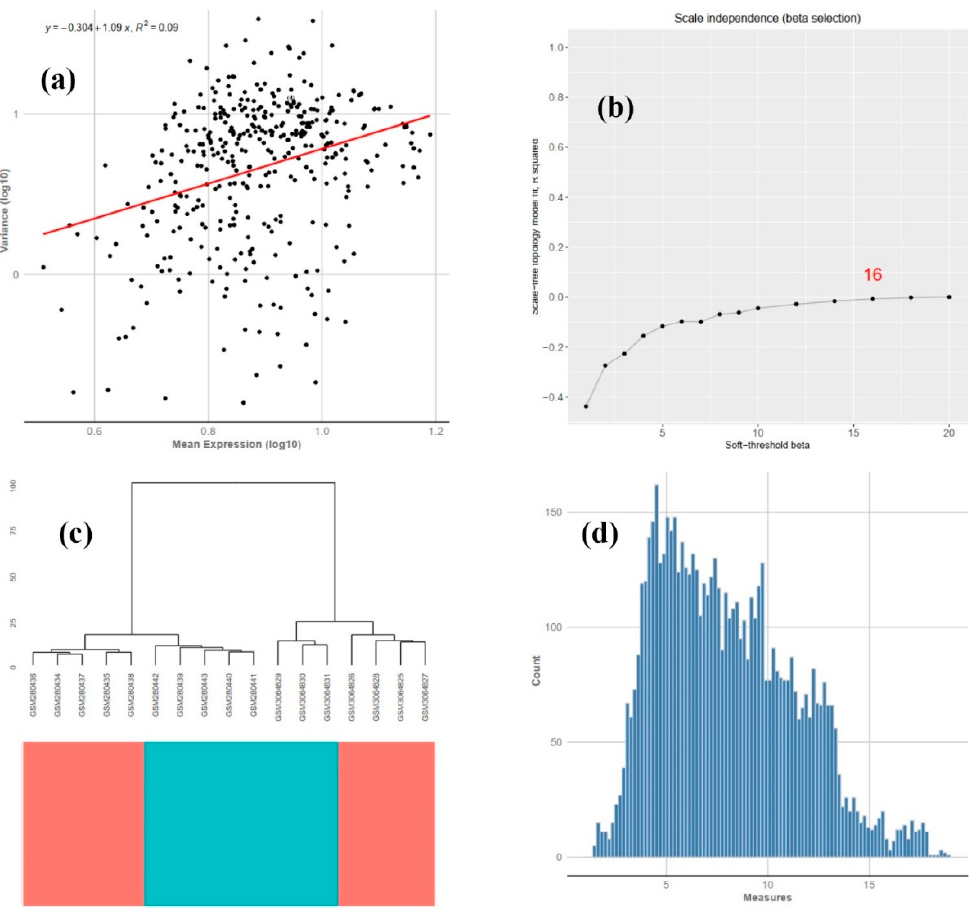
Figure 6. Mean-variance trend ( a ), beta-r2 detection ( b ), sample tree ( c ), histogram ( d ) of DEGs affected by starvation in zebrafish.